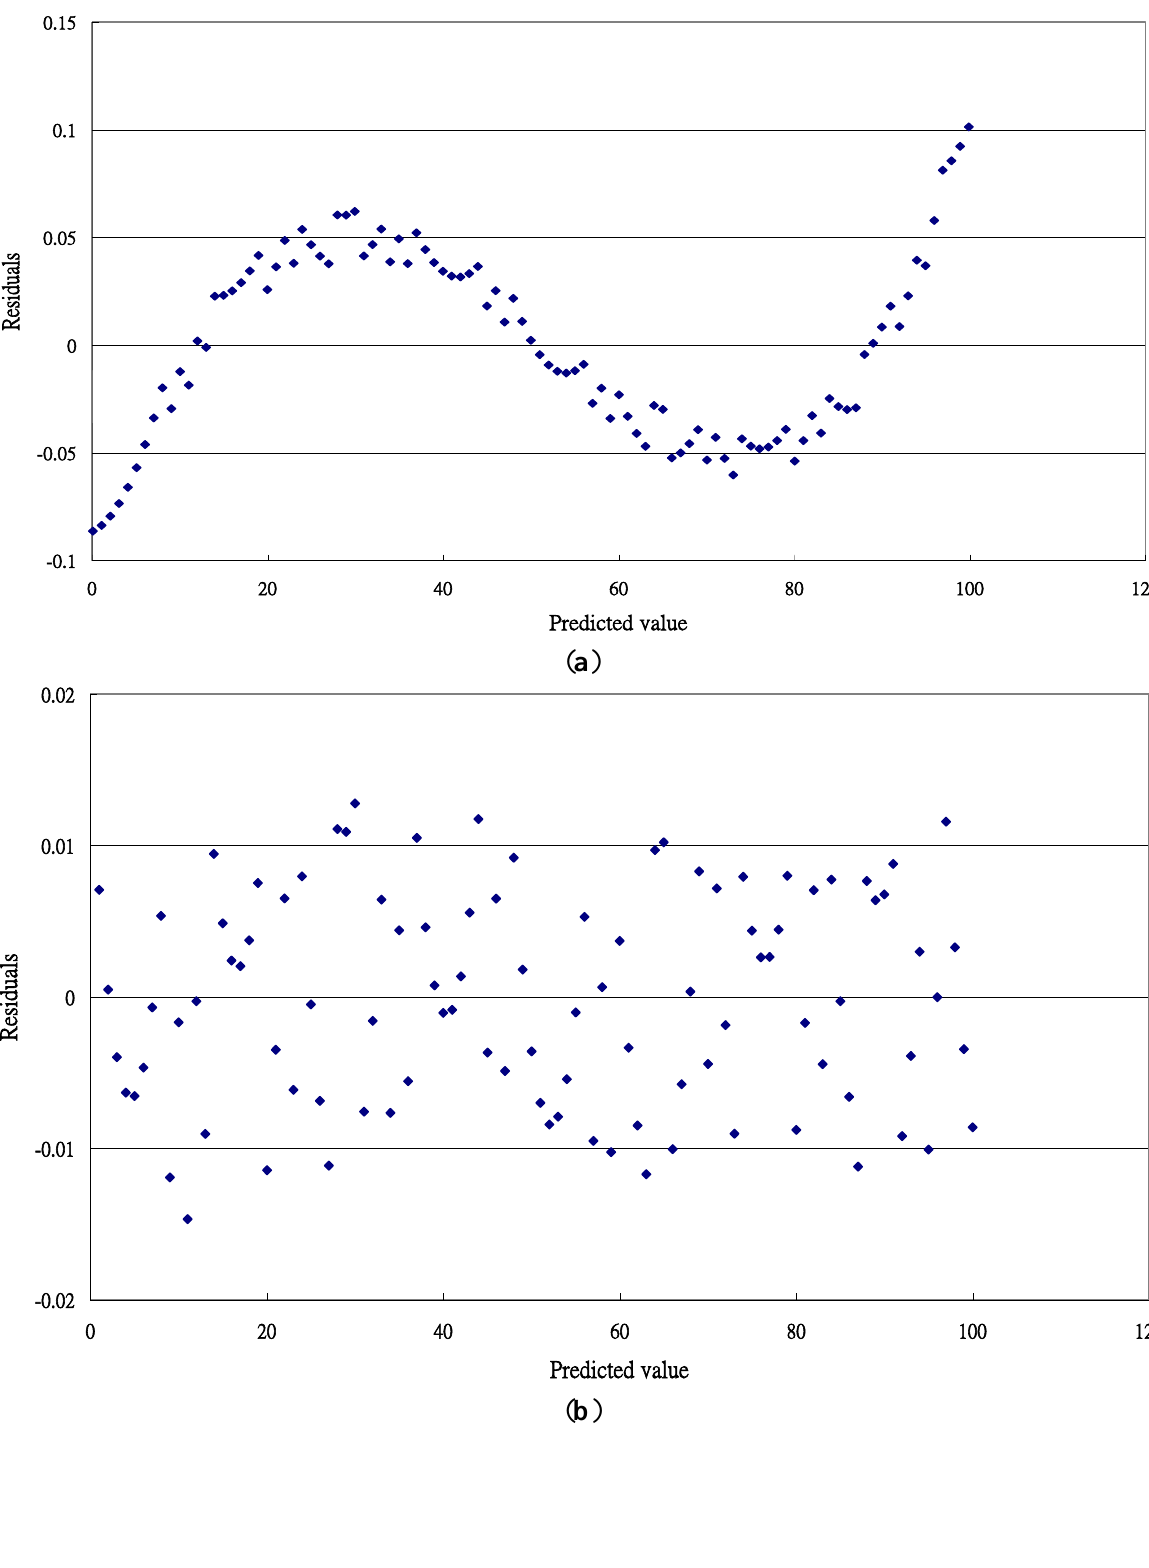
Figure 3. Residual plots of polynomial calibration equations for T-type thermocouples with temperature 0 to 100 °C . ( a ) 2nd order polynomial equation; ( b ) 3rd order polynomial equation; ( c ) 4th order polynomial